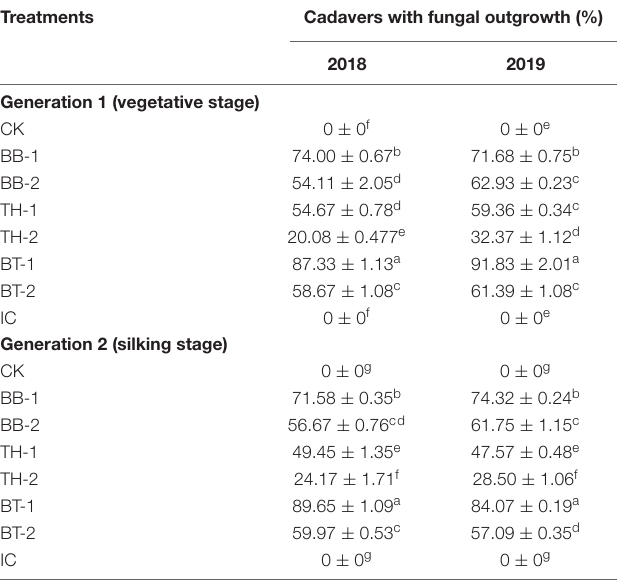
TABLE 4 | Percentage (%) of cadavers showing fungal outgrowth collected from the field. Treatments Cadavers with fungal outgrowth (%)